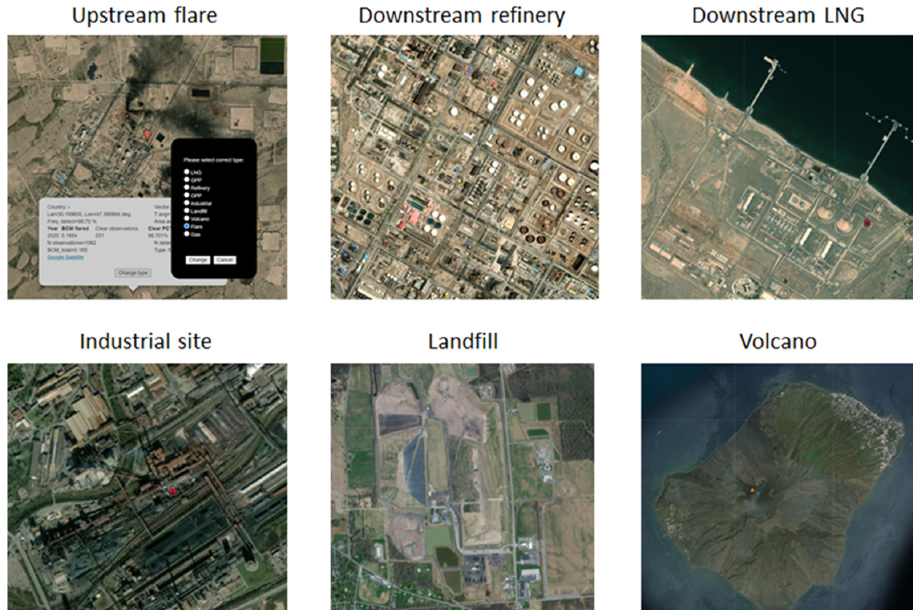
Figure 2. Examples of high spatial resolution imagery available in Google Earth for hotspots de- tected with VIIRS Nightfire produced by oil and gas sector related gas flares (first row) and other anthropogenic and natural sources (second row).